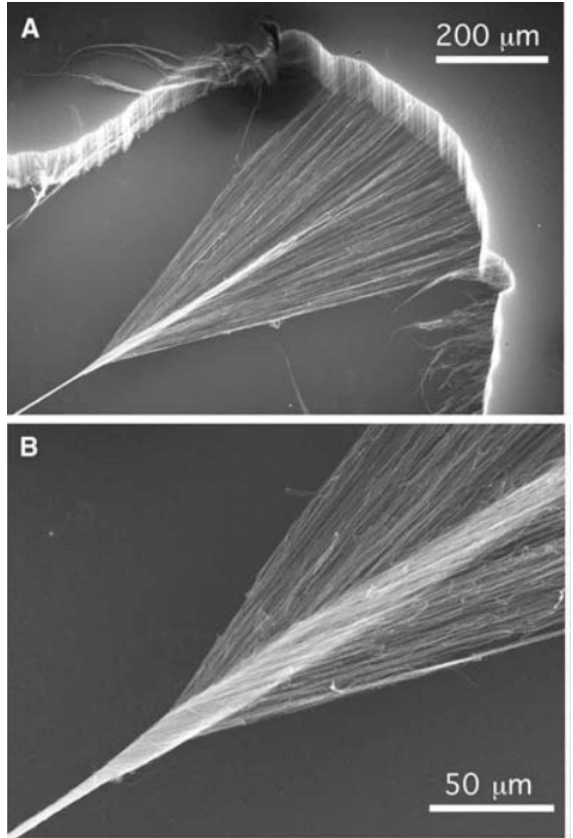
Figure 6. ( A ) Pulling method from a CNT vertical forest to produce CNT yarns and ( B ) CNT fibre produced by twisting of CNT yarns Courtesy of Science. Reproduced with permission from [30].